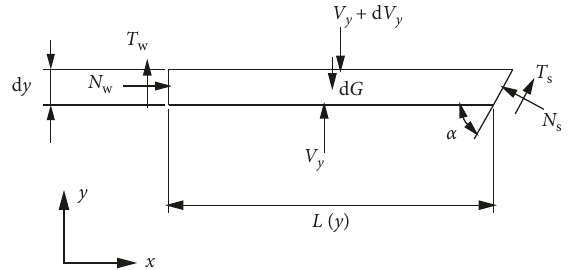
Figure 4: Force analysis of the differential horizontal backfill